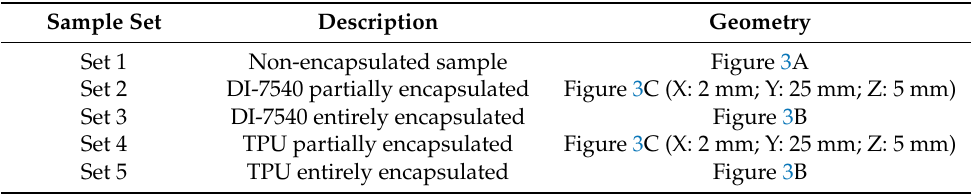
Table 2. The description of all sample sets corresponded to the Figure 3.